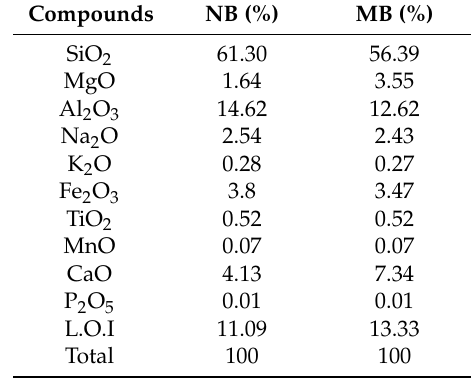
Table 2. Chemical compositions of NB and MB: XRF (X-ray fluorescence spectrometer) data; L.O.I. (Loss on ignition).